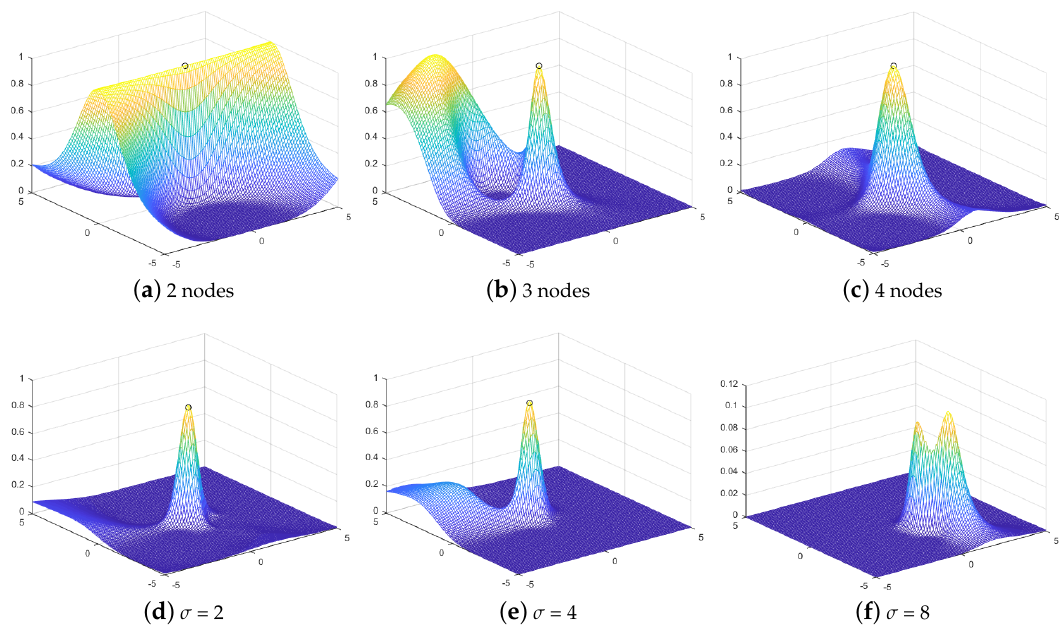
Figure 3. The value of the metric on different locations within the rectangular grid of [ − 5,5 ] × [ − 5,5 ]